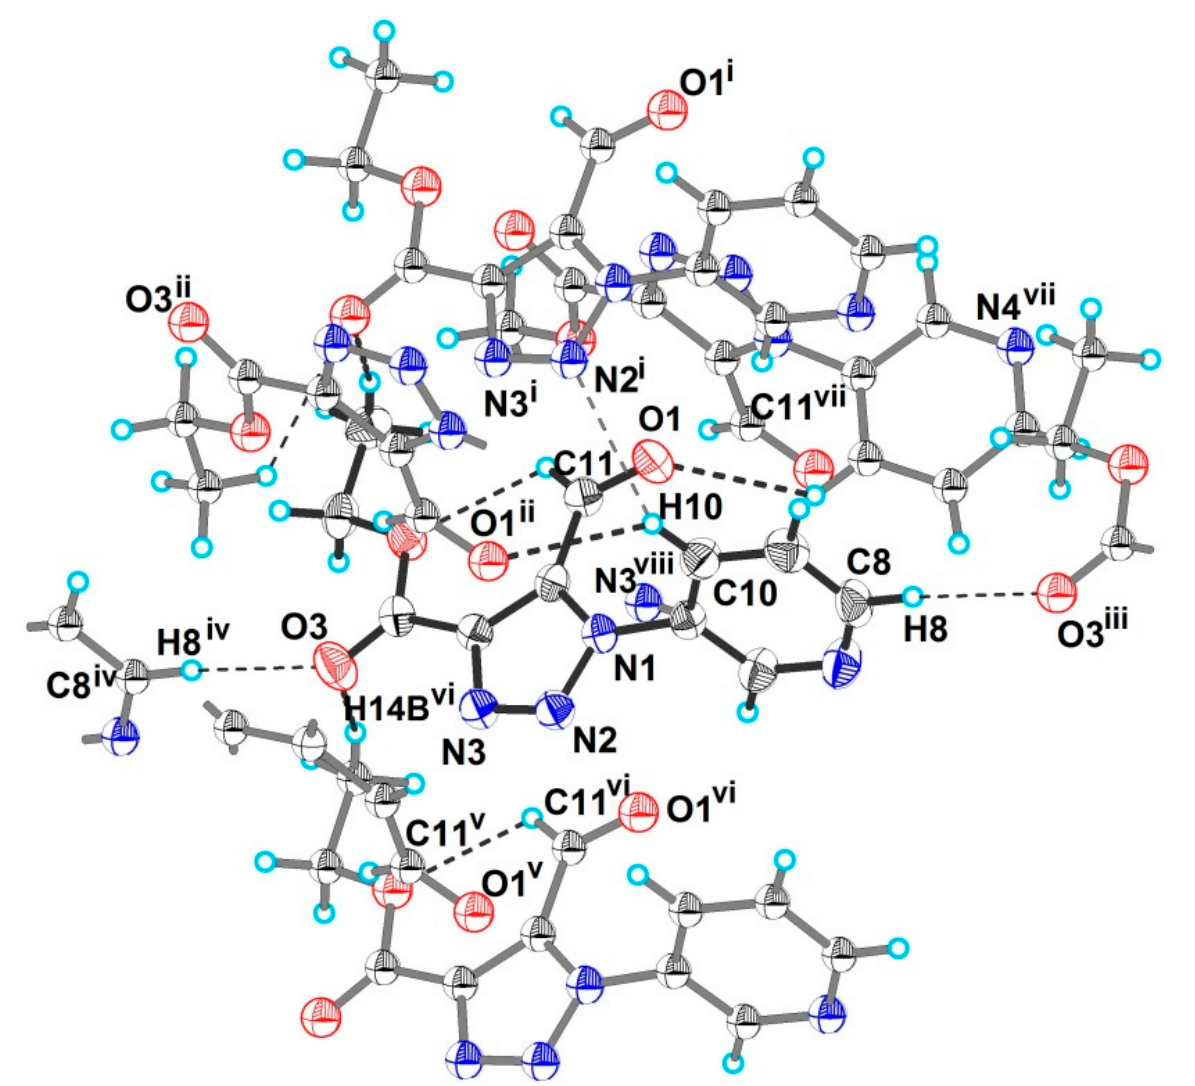
Figure 2. The hydrogen bonding of molecules in crystal structure of 4 . Hydrogen bonds are shown as dashed lines. Symmetry codes: (i) x , y + 1, z ; (ii) x , − y + 2, z + 0.5; (iii) x + 0.5, y + 0.5, z ; (iv) x − 0.5, y − 0.5, z ; (v) x , − y + 1, z + 0.5; (vi) x , y − 1, z ; (vii) x , − y + 2, z − 0.5, (viii) x , − y + 1, z − 0.5.